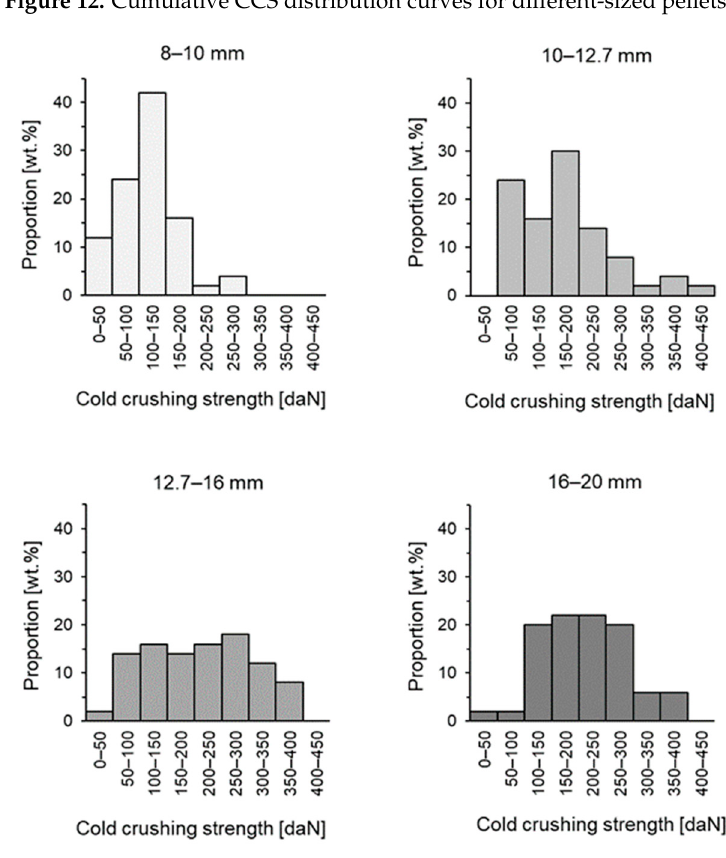
Figure 13. CCS histograms of the different-sized pellets.